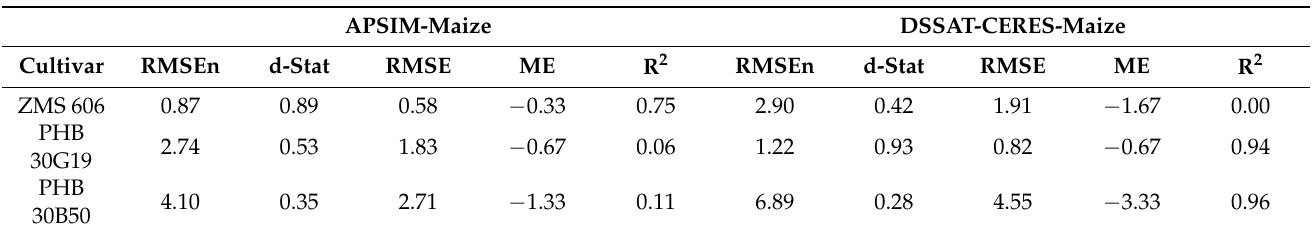
Figure 3. Overall calibration statistics between the observed and simulated values for the APSIM-Maize and DSSAT-CERES-Maize models using 1:1 graphs under rainfed conditions. The graphs show simulated vs. observed values for the anthesis (DAP), maturity (DAP), grain yield (t ha − 1 ), aboveground biomass (t ha − 1 ), mLAI (m 2 m − 2 ) and grain number m − 2 . Table 6. APSIM-Maize and DSSAT-CERES-Maize model calibration statistics for the days after planting (DAP) to anthesis for maize cultivars under rainfed conditions.